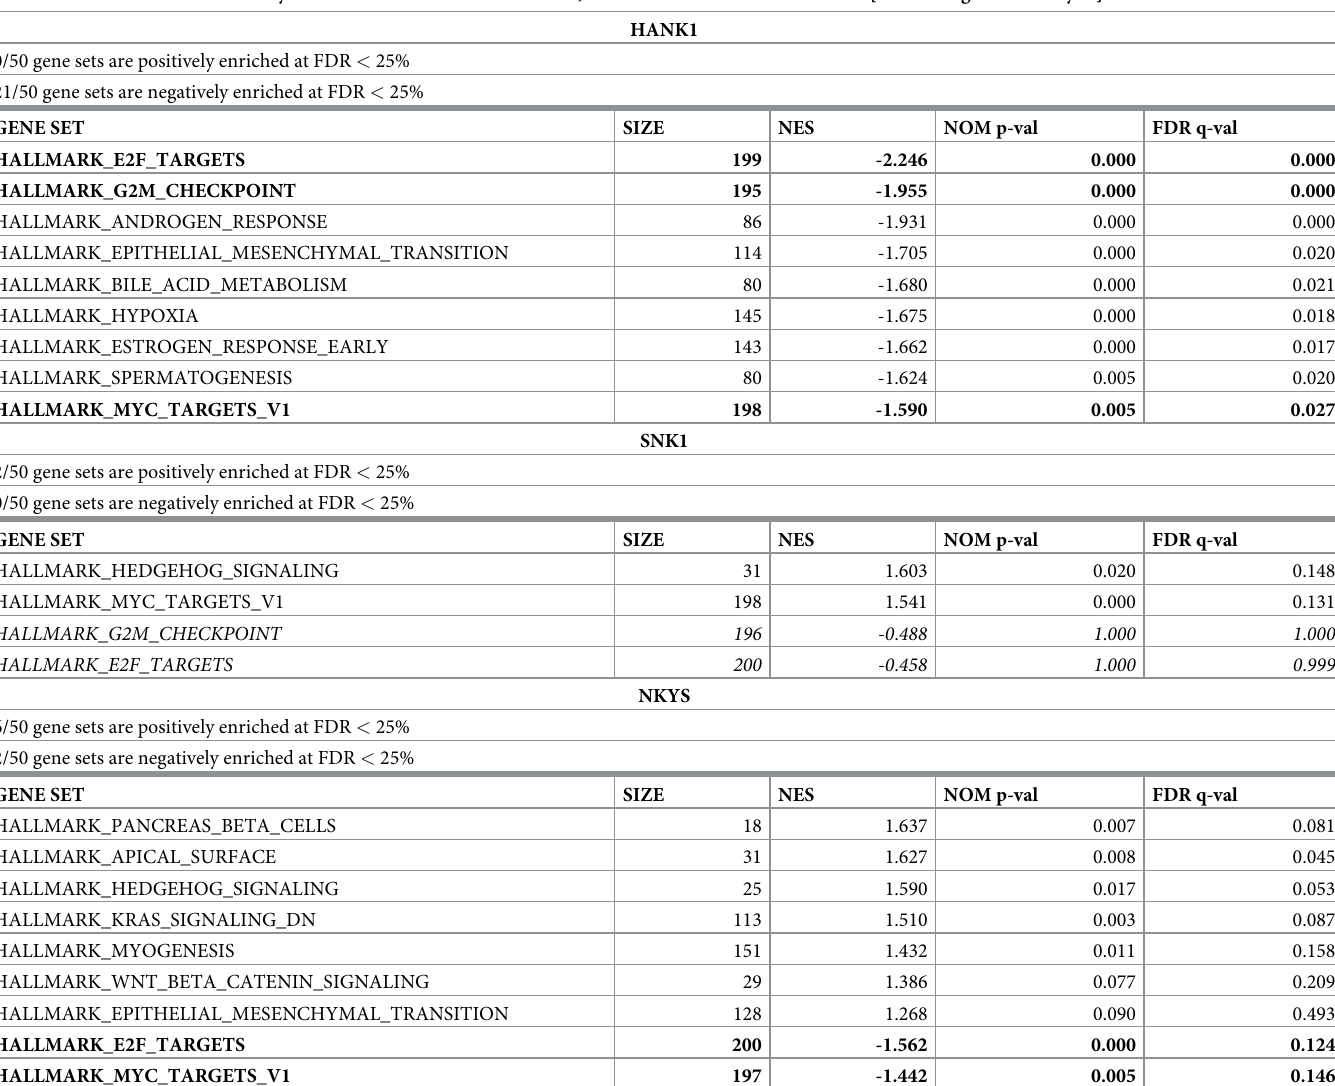
Gefitinib has been shown to selectively induce cell death in ZAP-70 expressing CLL [22]. In Fig 1 we have shown a range of T and NK lymphomas with varying levels of ZAP-70